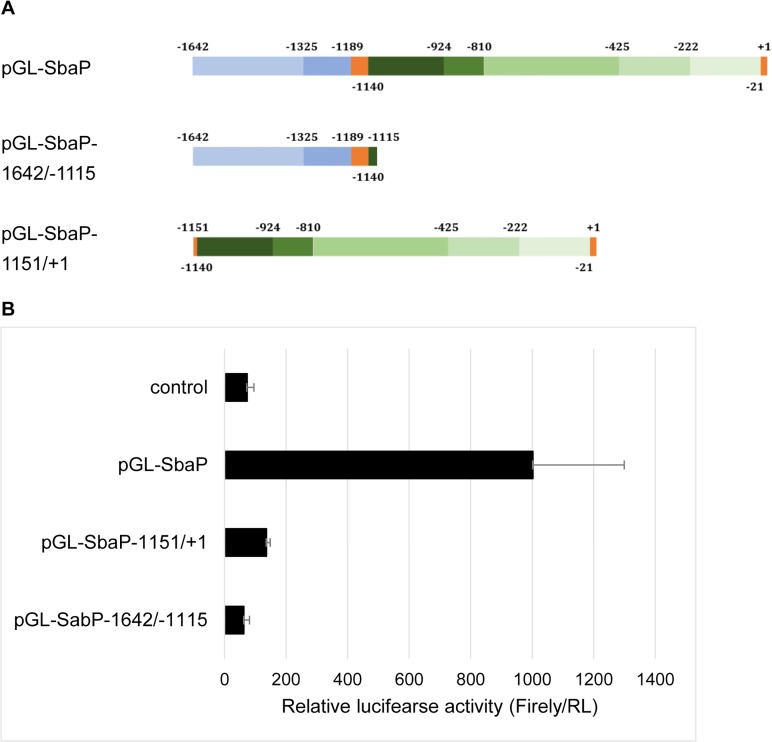
Examination of activity of 5’-upsream sequences and 1st intron of the shrimp β-actin gene based on a reporter assay.A: schematic diagram of promoter region of luciferase reporter gene constructs. Showing various 5’-flanking sequence sequences of shrimp β-actin gene fused with luciferase gene. B: the relative levels of reporter gene expression in sf21 cells are shown. The constructs were transiently co-transfected into cells along with pRL-tk control vector. The activity of firely and Renilla luciferase in the cell lysate were measured using Dual-luciferase reporter assay (Promega) at 48h post transfection. Firefly luciferase activity was normalized to Renilla luciferase activity. The Bars indicated mean ±S.D. of luciferase activity (n = 3).